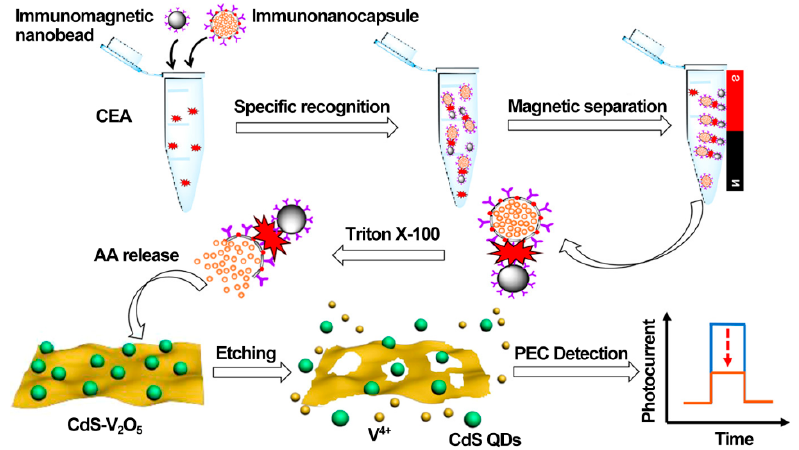
Figure 7. Illustration of the PEC immunoassay for the detection of CEA. Reprinted with permission from ref. [103]. Copyright 2020 American Chemical Society.